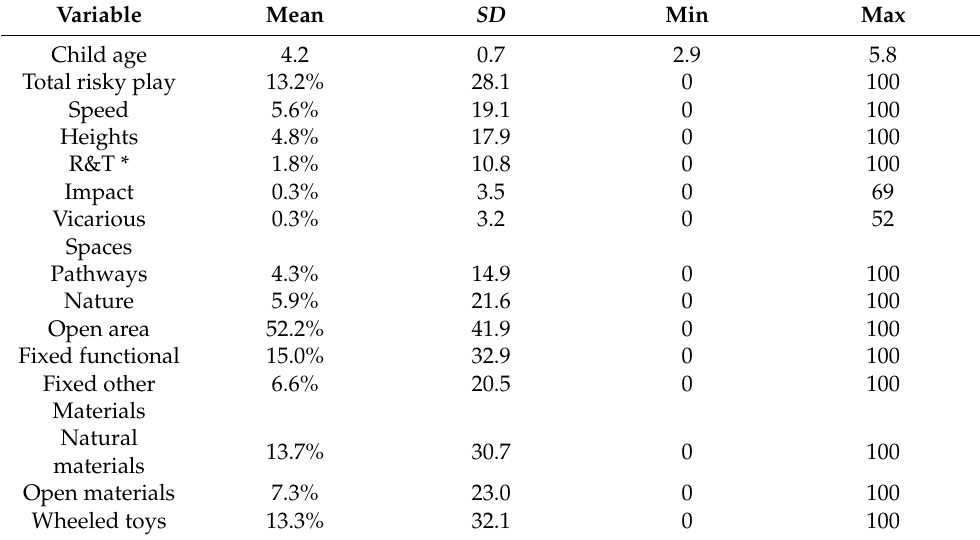
Table 1. Descriptive statistics ( n = 935 observations).